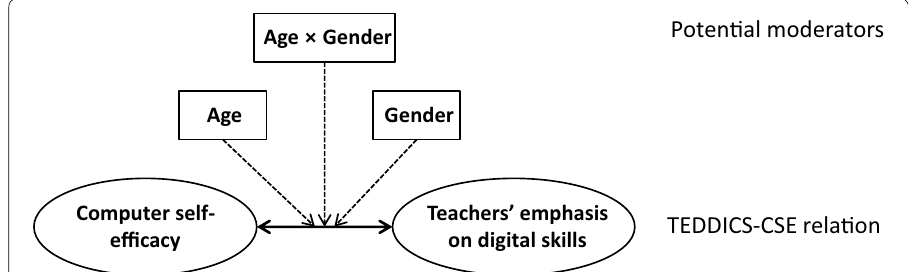
Fig. 1 Conceptual model describing the moderating role of teachers’ age, gender, and their interaction for the relation between CSE and